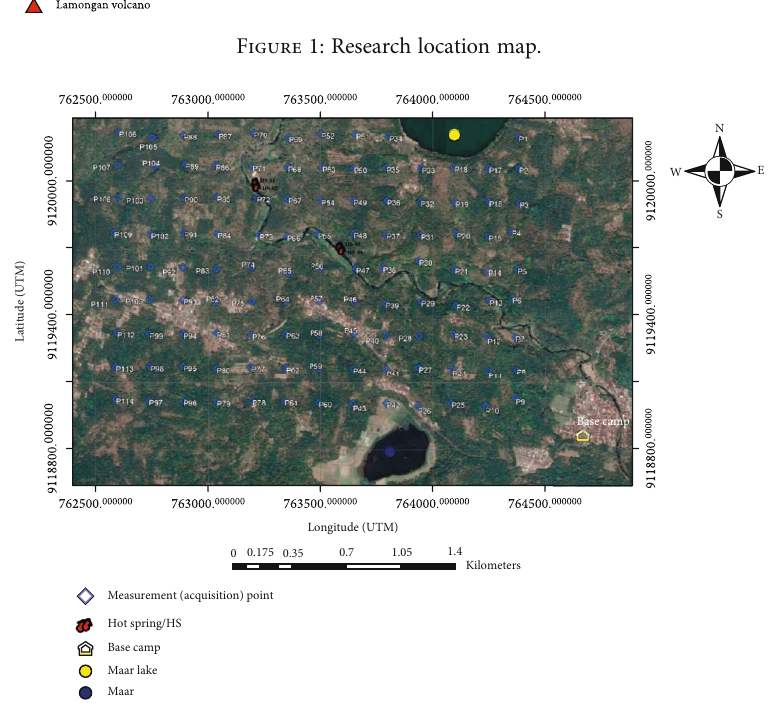
Figure 2: Google Earth-based gravity acquisitions